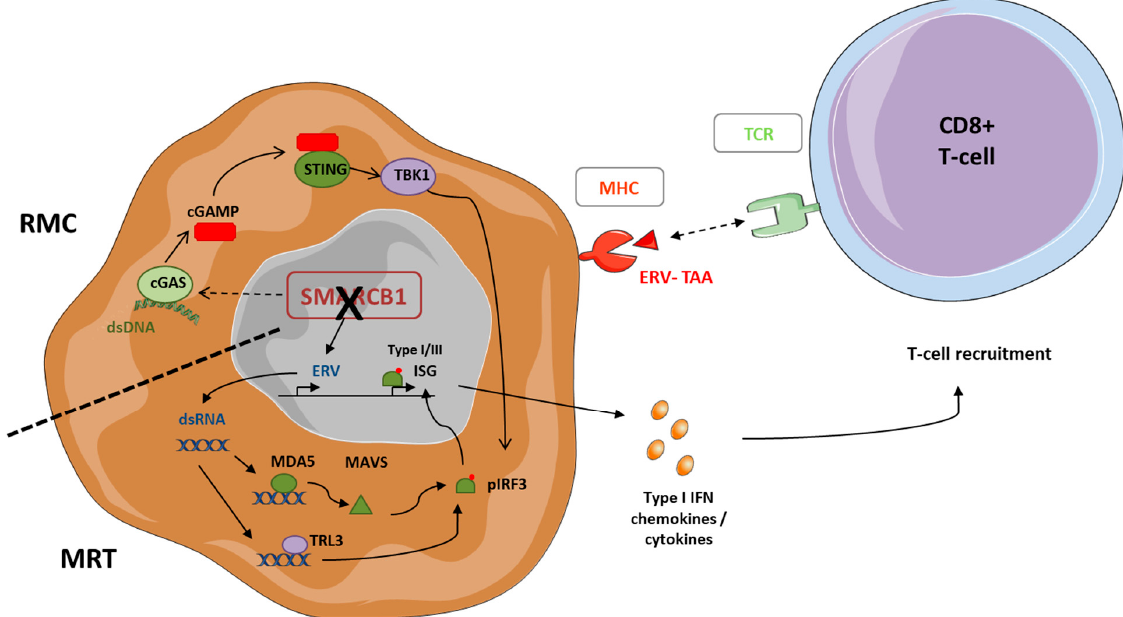
Figure 2. Interplay between SMARCB1 deficiency and immune modulation in SMARCB1-deficient MRT and RMC. Bottom right part of the tumor cell: in MRT, ERVs de-repression contributes to the accumulation of the cytosolic double-stranded RNA (dsRNA) which are recognized by the Toll-like receptor (TLR) 3 and MDA5 sensors. MDA5 binds to MAVS resulting in a signaling cascade which promotes the phosphorylation and nuclear translocation of IRF3, and subsequent induction of type I/III interferon-stimulated genes (ISG). This overall results in cytokine production which favors the recruitment of TILs. Aberrantly expressed ERV may also contribute to the development of an adaptive immune response through the production of tumor associated neoantigens (TAA). Upper left part of the tumor cell : in RMC and within a context of MYC-induced replication stress, dsDNA is released in the cytoplasm, which activates the cGAS/STING DNA-sensing pathway. The DNA sensor cGAS binds to dsDNA, which triggers the formation of cyclic G-AMP (cGAMP), and subsequently activates STING. cGAMP-bound STING recruits TBK1 and phosphotylates IRF3, which translocates to the nucleus where it triggers the expression of ISG.